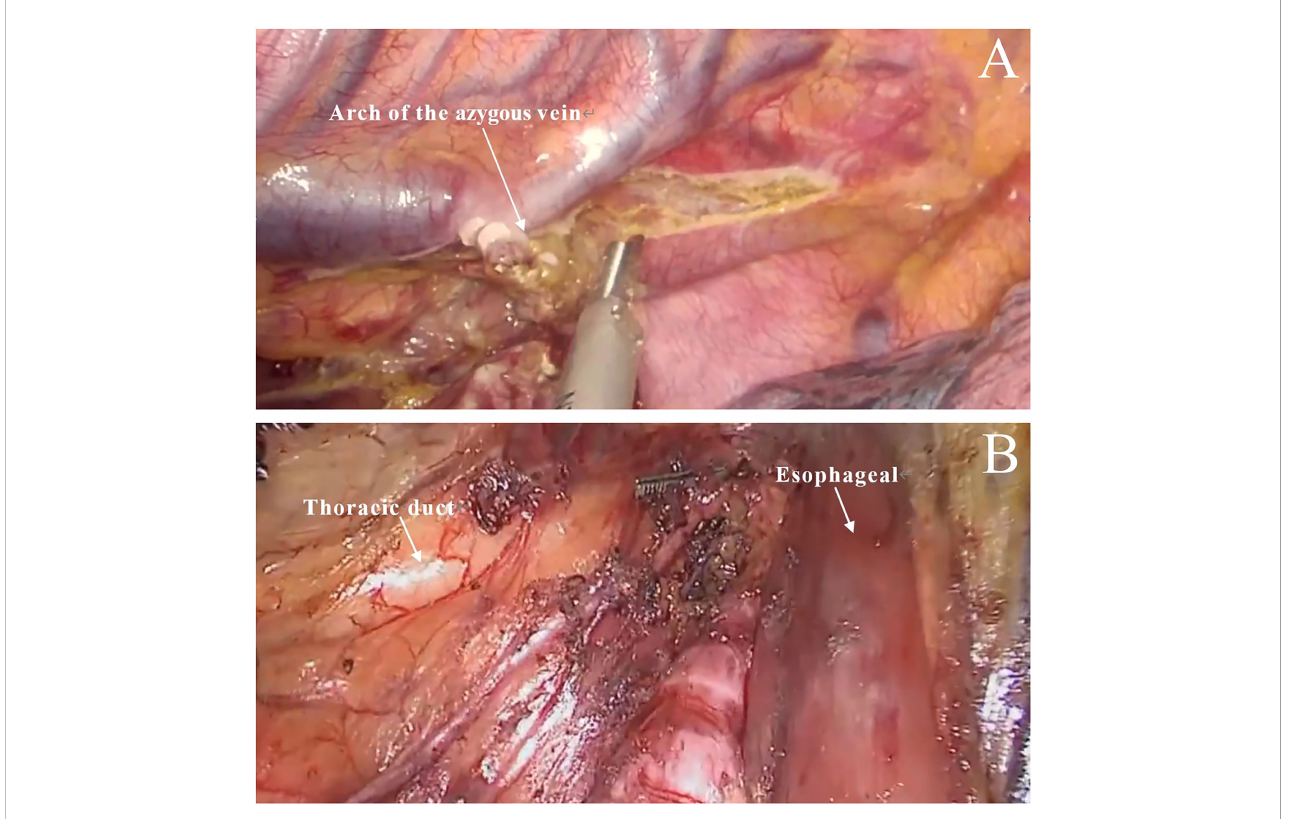
FIGURE 2 Modi fi edtechnique. (A) Only thearchofthe azygous veinwas cut (theposterioresophagus, azygous veinandsurroundingtissueswerepreserved). (B) The thoracic